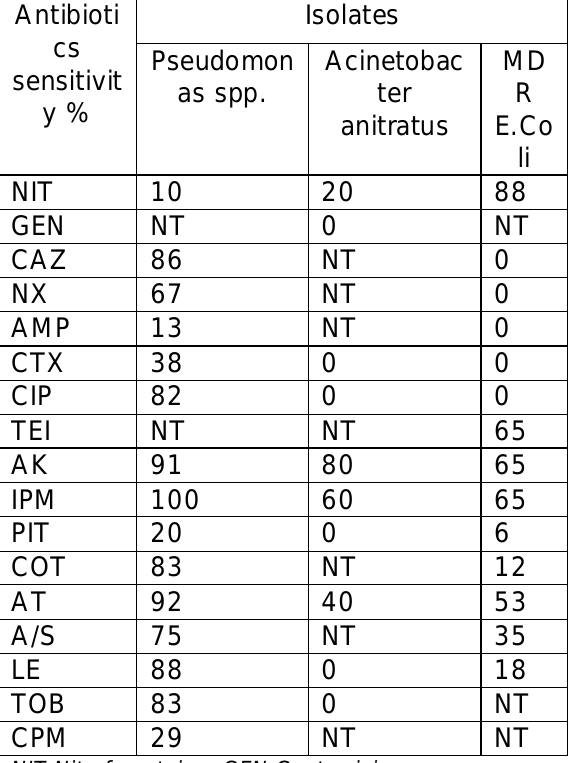
Table 6: Antibiotic Sensitivity Pattern Of Pseudomonas, Acinetobacter anitrarus And MDR